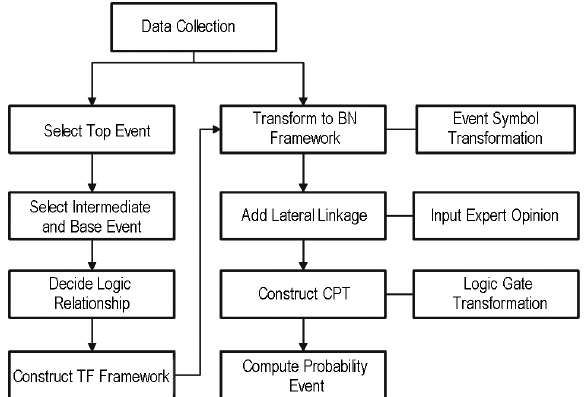
Fig. 2. Transformation flow chart from FT to